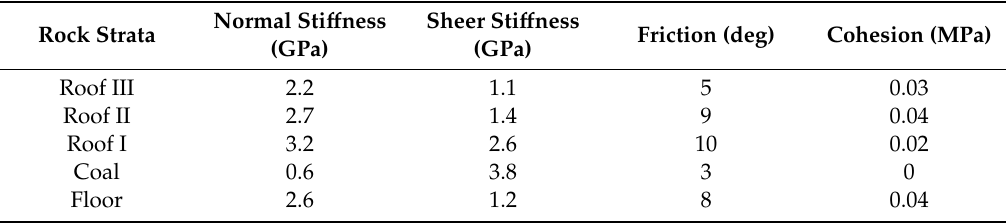
Table 2. Rock joint plane mechanical parameters in model.